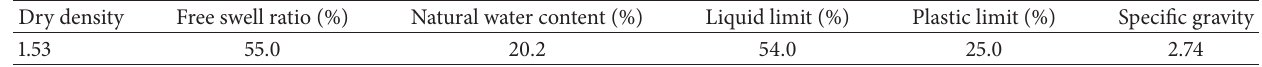
Table 1: Physical properties of expansive